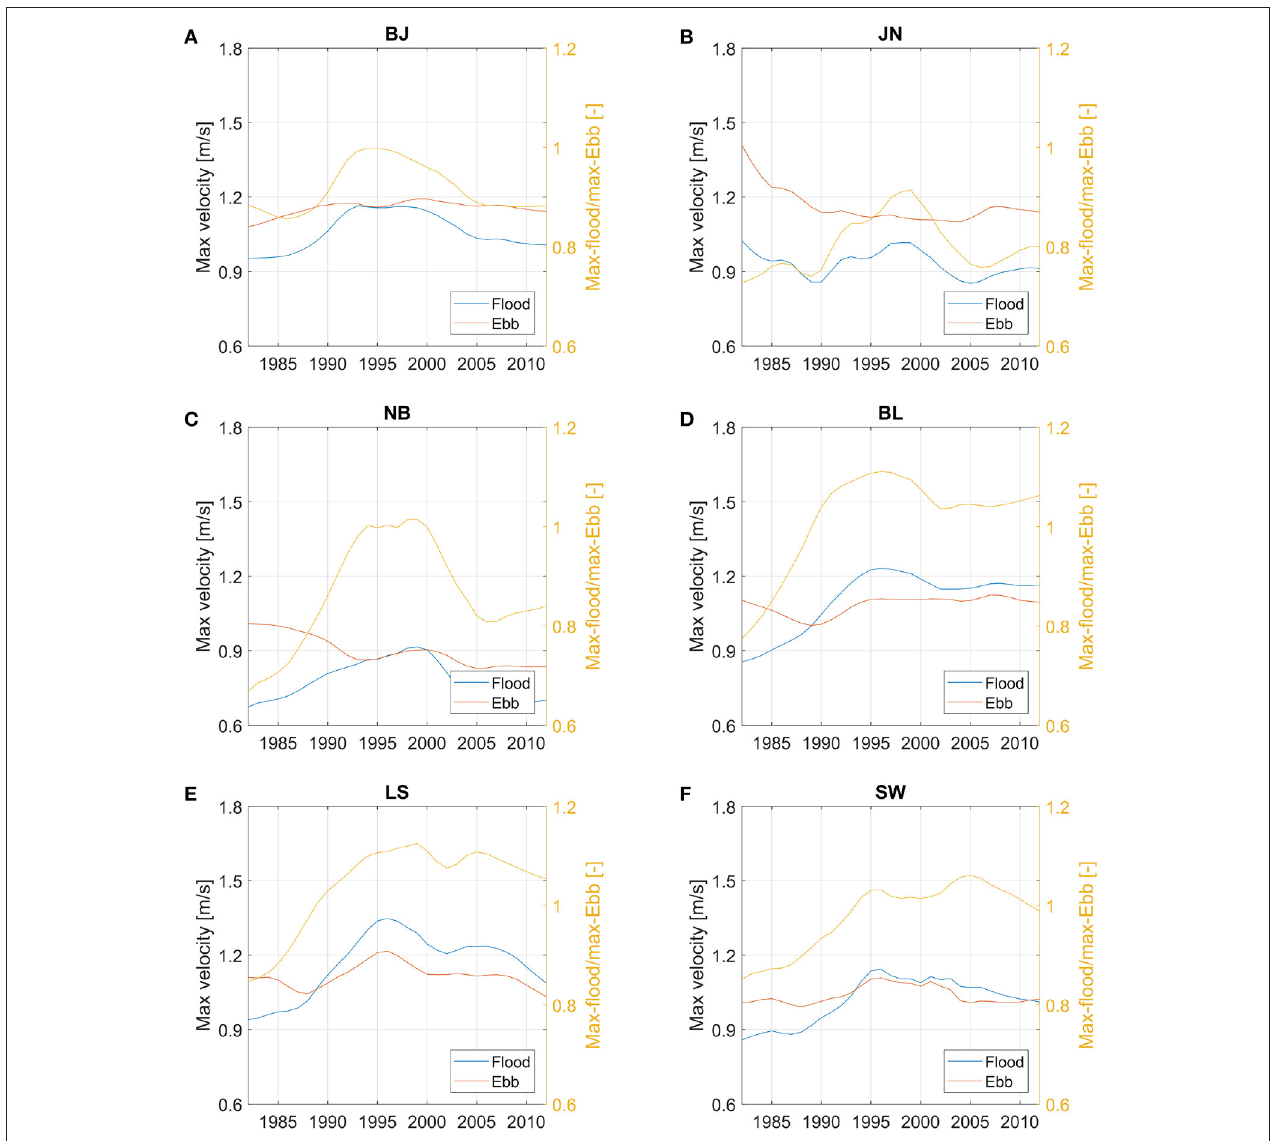
FIGURE 8 | Maximum flood and ebb velocities in the tidal basins of the EFWS: (A) Borkum Juist (BJ), (B) Juist Norderney (JN), (C) Norderney Baltrum (NB), (D) Baltrum Langeoog (BL), (E) Langeoog Spiekeroog (LS), and (F) Spiekeroog Wangerooge (SW).